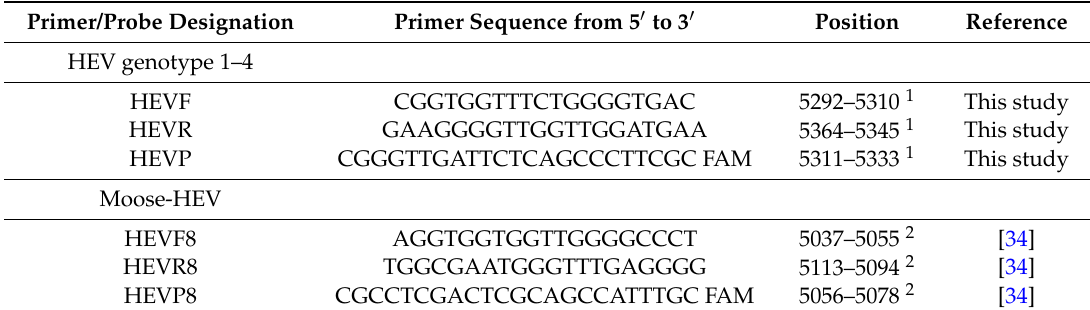
Table 1. Primers and probes used in the real-time RT-qPCR assays for detection of HEV1-HEV4, and